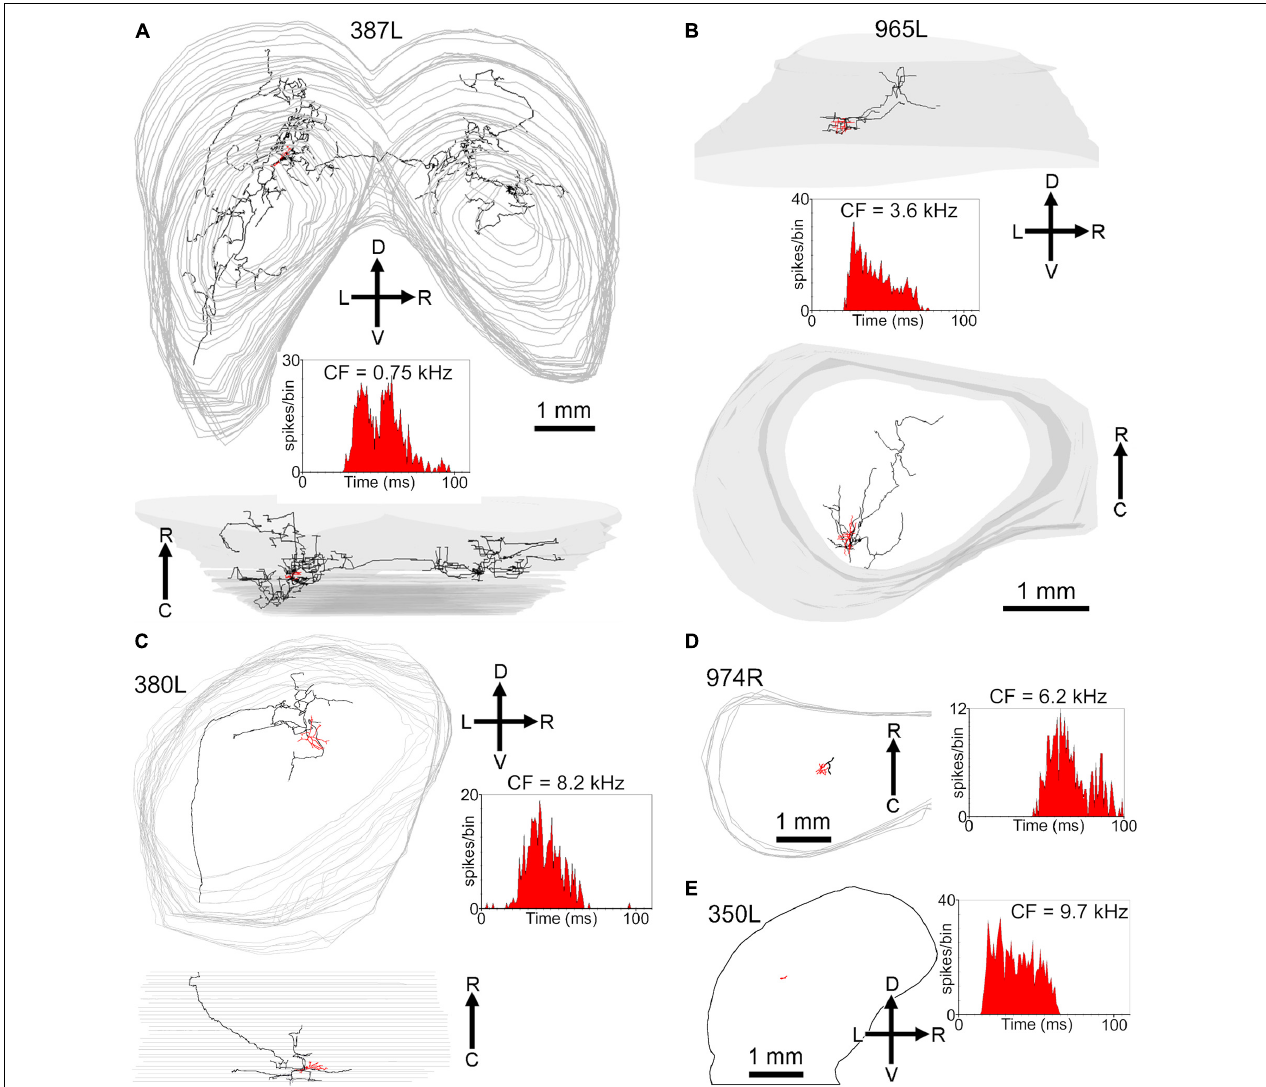
FIGURE 8 | Reconstructions of the axonal ramifications of four long-latency cells and one with an unstained axon, with somata located in the ICc. The first four cells have long latencies of 24–43 ms as indicated in Table 2 . (A) Medium less-flat, ovoid cell located at the lateral edge of the ICc with an extensive axon that terminates in the lateral and dorsal cortex as well as bilaterally in the ICc. (B) Medium spherical stellate located in the ICc with an axon that terminates in the same lamina as the soma but also in others nearby. (C) Medium ovoid stellate cell located in the ICc with an axon that has terminal branches in multiple laminae and leaves the ICc via the brachium. (D) Small flat disk cell in the middle of ICc with a very short portion of stained axon. (E) Small ovoid stellate cell in the ICc with a sustained response (latency 15 ms) and an unstained axon.